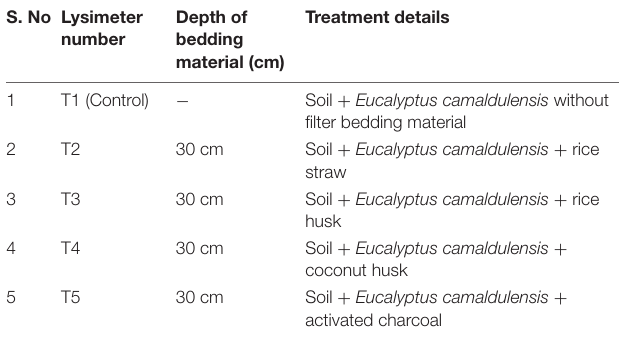
TABLE 1 | Treatment details of experiment and the FBM.